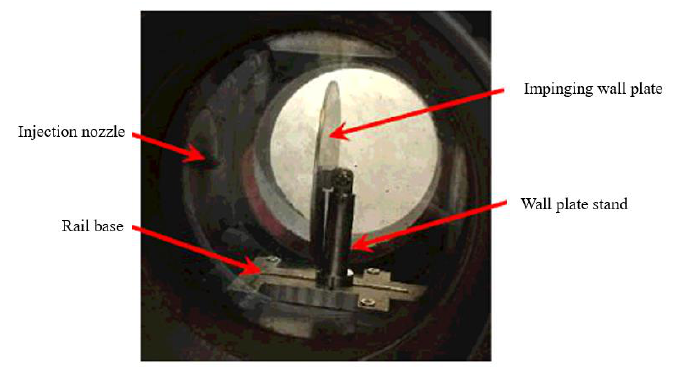
Figure 4. Wall plate impingement